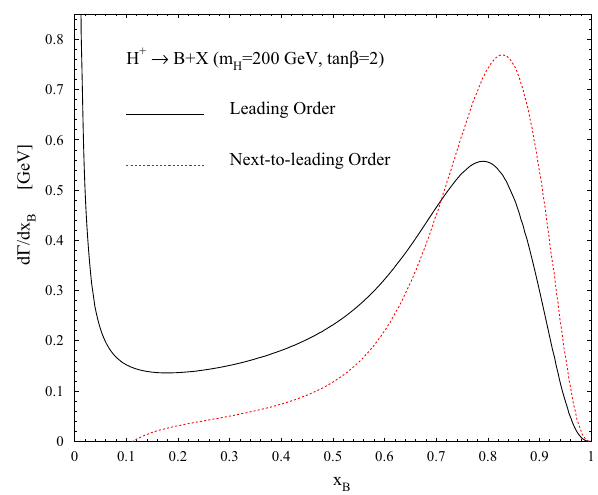
Fig. 1 The x B spectrum in heavy charged Higgs decay in the 2HDM. The NLO result (dashed line) is compared to the LO one (solid line) taking tan β = 2 and m H + = 200